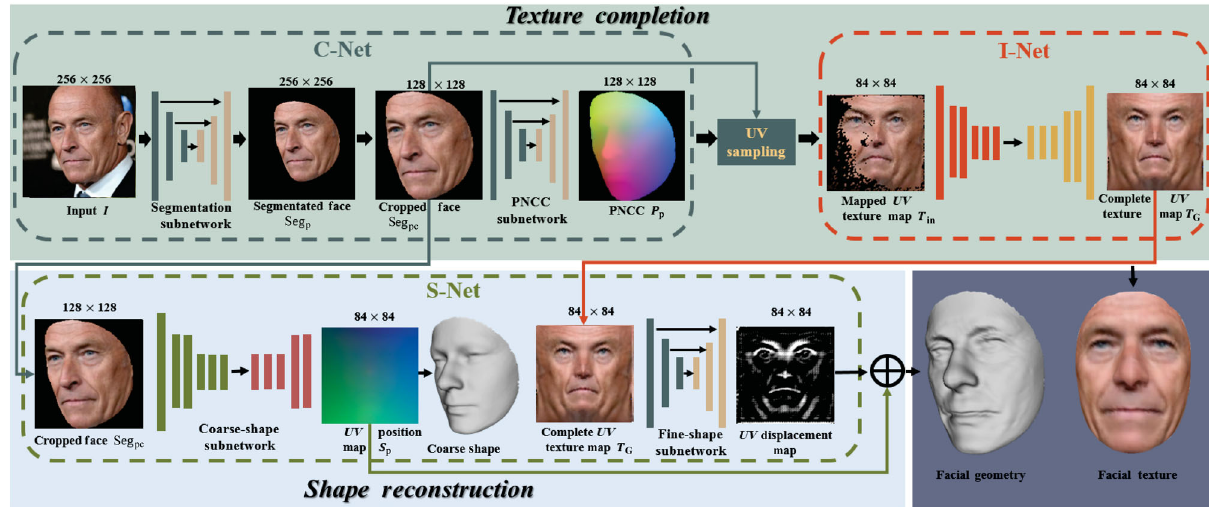
Fig. 2 Pipeline of our SRTC-Net. It jointly infers 3D facial geometry and complete texture from a single image via three modules: C-Net, I-Net, and